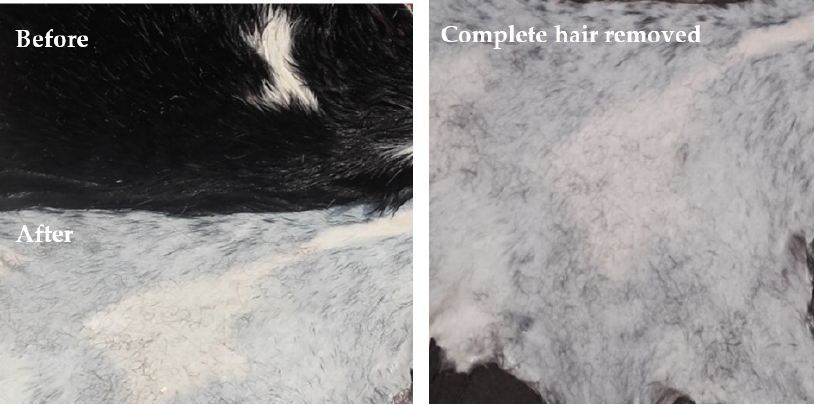
Figure 8. Dehairing activity of alkaline protease produced by Bacillus cereus.